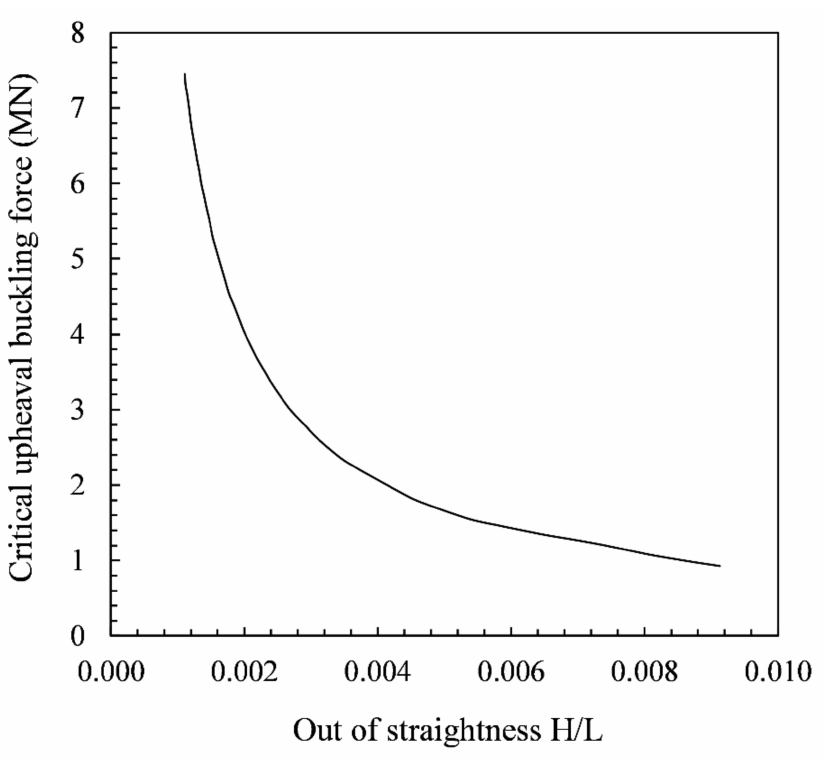
Figure 3. Influence of initial pipe imperfection on critical buckling force [14]. Table 1. Parameter used in the Numerical models for uplift resistance of surface laid